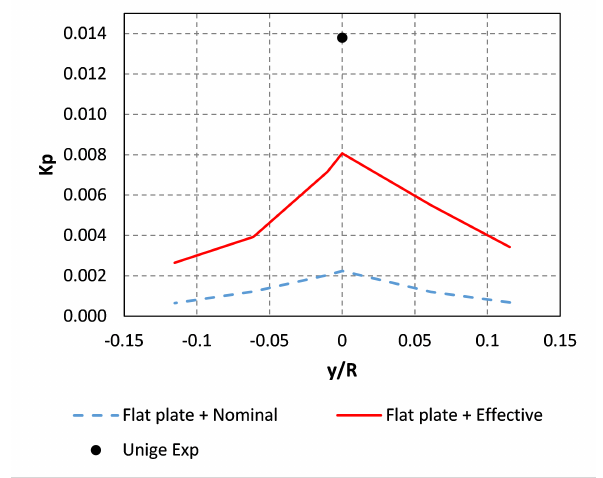
Figure A.9: Comparison between predicted and measured pressure pulses (fourth harmonic) in cavitating condition on the transver- sal section in correspondence of the propeller disk. (no full-scale measurements